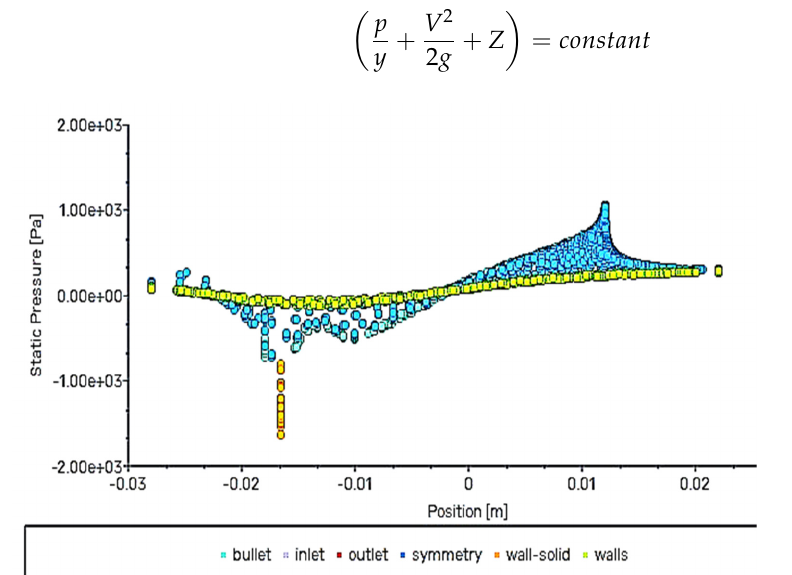
Figure 14. The plot between static pressure and position.